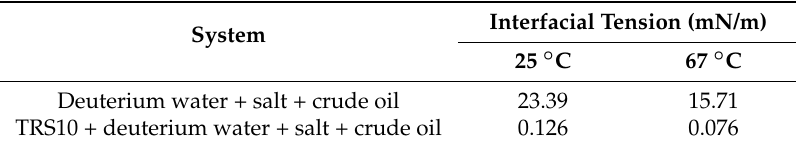
Table 2. Interfacial tension of different systems.